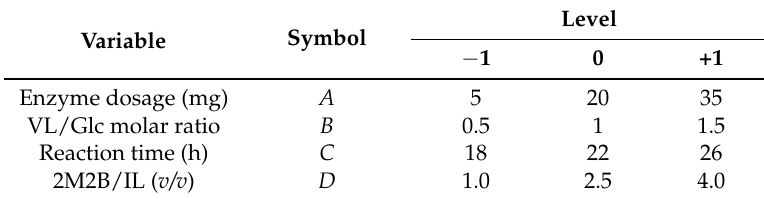
Table 3. Variables and levels used for the Box–Behnken design.